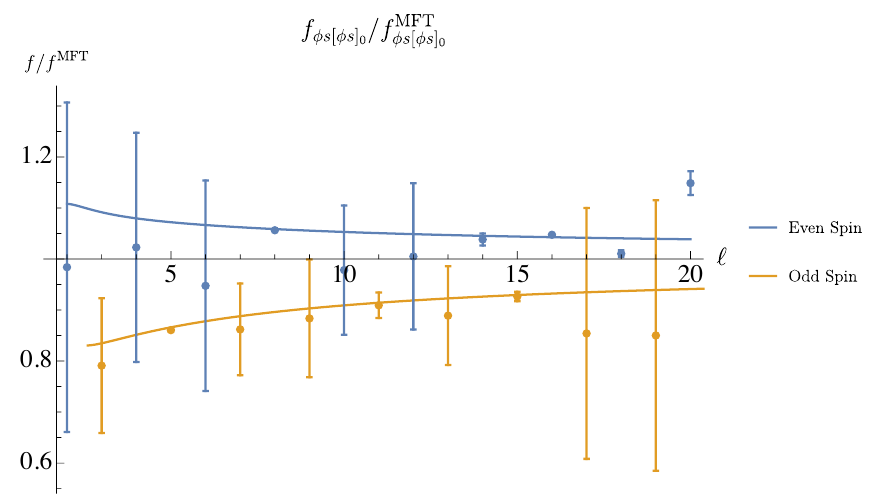
Figure 8 . Analytic and numerical predictions for twists of the double-twist trajectories [ (cid:30)s ] 1 with charge 1 and odd spin. The blue curve represents the [ (cid:30)s ] 1 represents the [ (cid:30)t ] 1 trajectory. 0